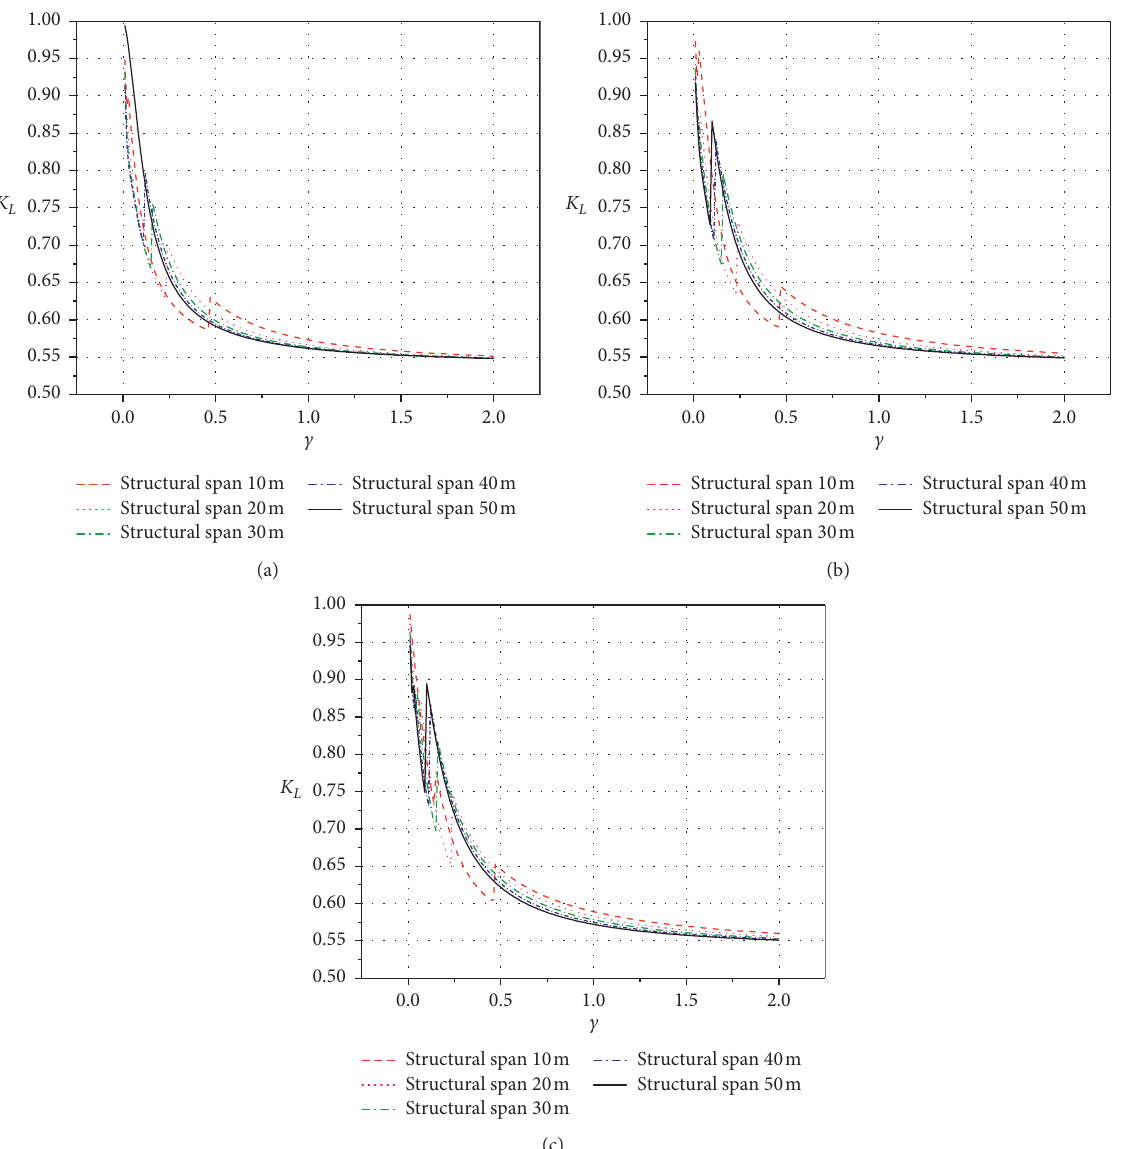
Figure 7: Equivalent load transformation factors of fixed end one-way members using Henrych’s formula parameters: (a) W � 1kg. (b) W � 10kg. (c) W �